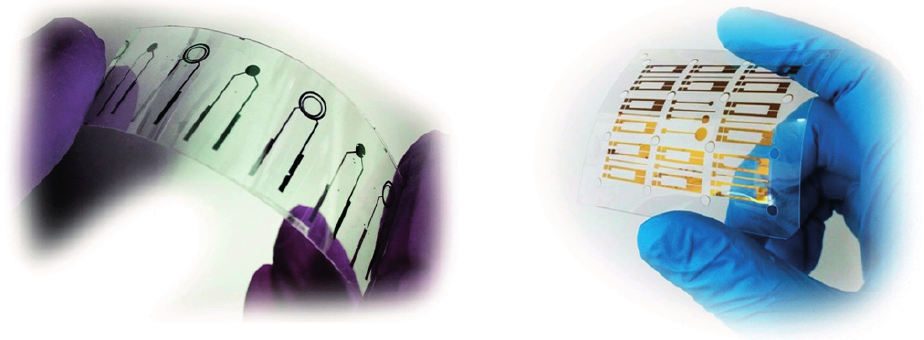
Figure 3. Flexible and disposable thin film field effect devices. Devices produced